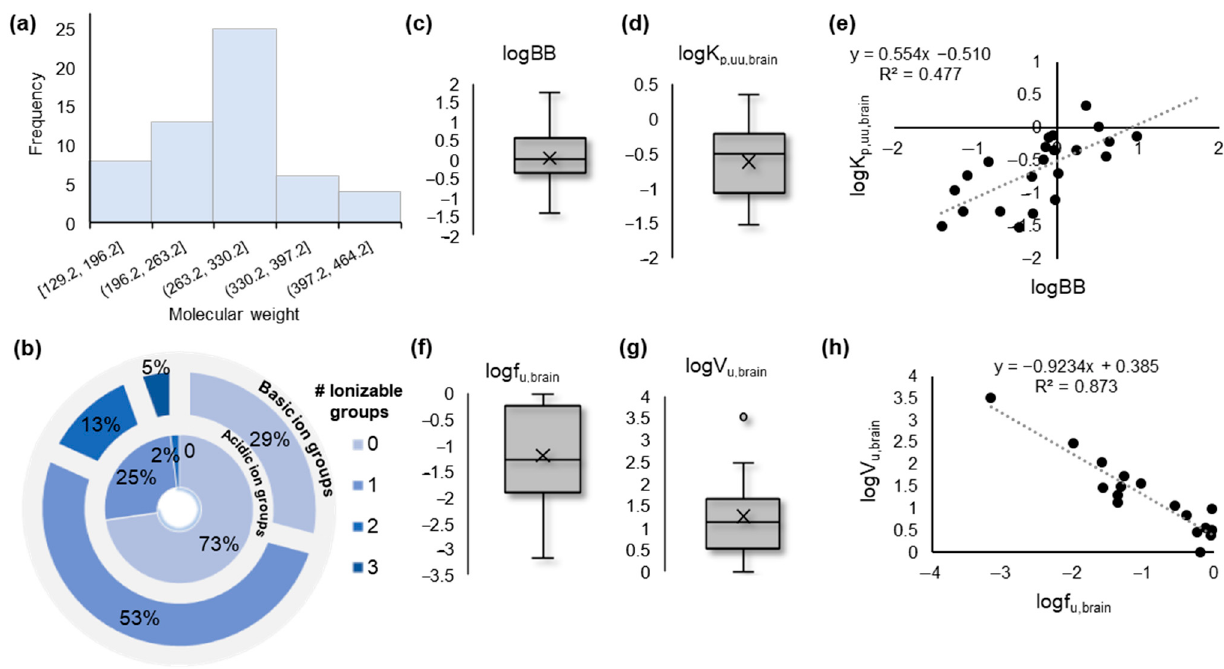
Figure 1. Overview of the data. ( a ) Histogram showing the distribution of the molecular weight of the investigated compounds; ( b ) Overlaid pie plots showing the number of ionizable groups (basic, outer layer; acidic, inner layer) present in the investigated compounds; ( c ) Box plot showing the distribution of the experimental logBB values collected from the literature; ( d ) Box plot showing the distribution of the experimental logK p,uu,brain values collected from the literature; ( e ) Correlation scatter plot between logBB and logK p,uu,brain values; ( f ) Box plot showing the distribution of the experimental logf u,brain values collected from the literature; ( g ) Box plot showing the distribution of the experimental logV u,brain values collected from the literature; ( h ) Correlation scatter plot between logf u,brain and logV u,brain values.